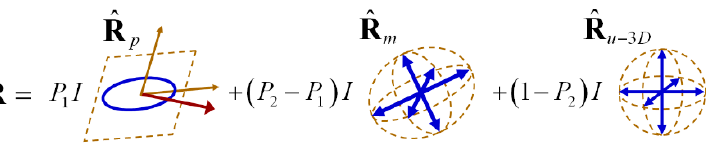
ˆ ˆ R is itself nonregular. R is itself nonregular. m m ˆ R is itself nonregular. m